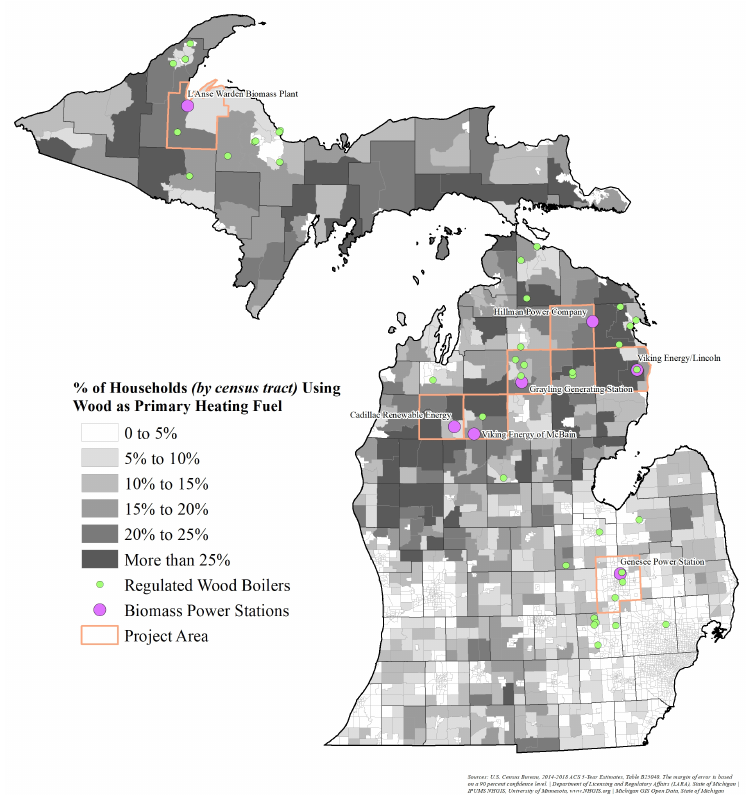
Figure 3. Map of three scales of wood energy in Michigan. 1. Shaded areas represent percent of households that use wood as a primary heat source. 2. Location of commercial-scale boilers in green. 3. Location of wood-burning power plants in purple. Counties that have biomass power plants are outlined in orange.